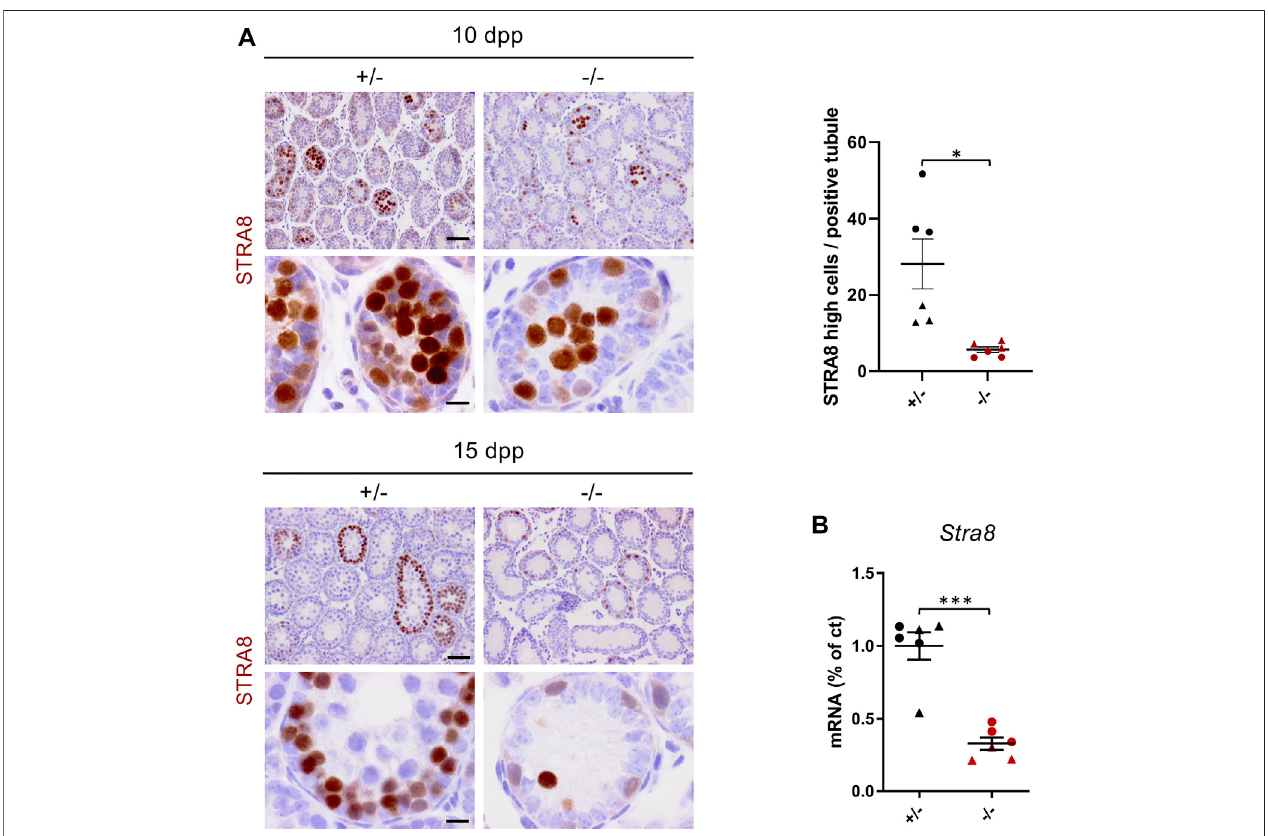
FIGURE 5 | Meiotic entry is not impaired in Cep250 -/- mutants. (A) Histological analysis of 10 dpp and 15 dpp testis sections stained for STRA8. Scale bar: 50 µm (upperpanels) and 10 µm (lower panels). Quanti fi cation ofthenumber ofSTRA8 high-positive cells per positive tubule isshown in thegraph. Triangles represent10dpp valuesandcircles represent 15dpp values.Mean ± SEM. * p < 0.05(two-wayANOVA). (B) Stra8 mRNAexpression levels weremeasured byRT-qPCRinthepost-natal testes. Triangles represent 10 dpp values and circles represent 15 dpp values. β -actin was used as an endogenous reporter. Data are expressed as a percentage of the control expression level. Mean ± SEM. *** p < 0.001 (two-way ANOVA).